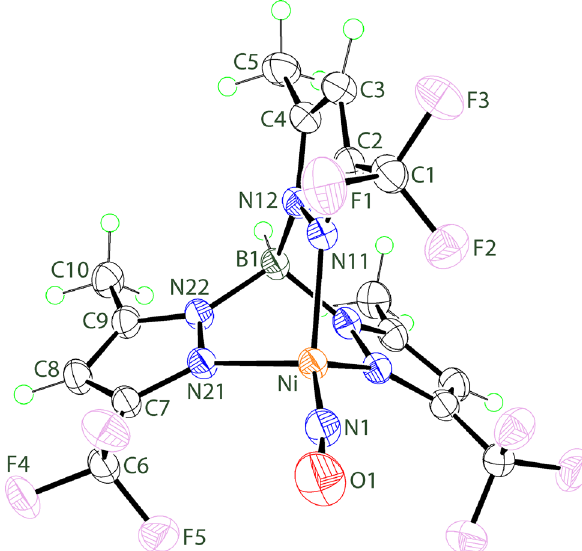
Table  : Data collection and